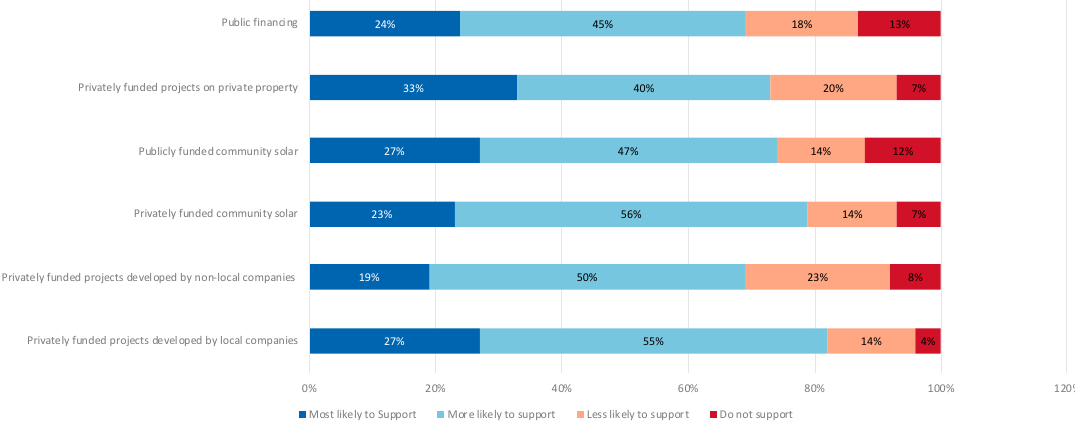
Figure 3. Reported Support for Financial Models. Table 1. Reported Support for Financial